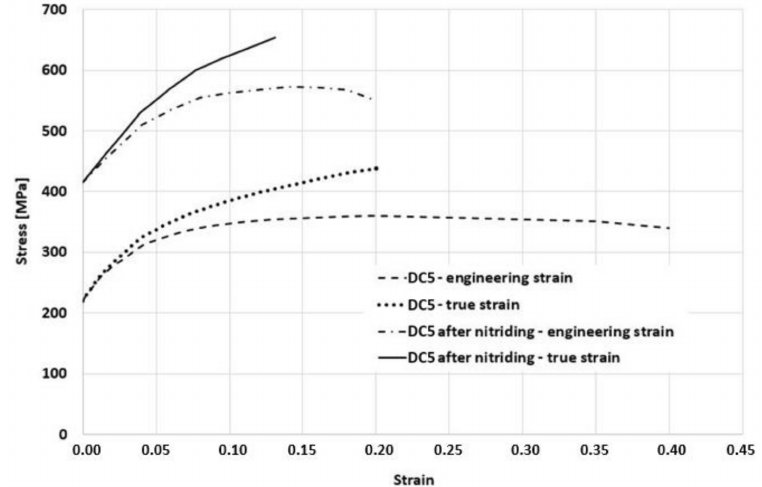
Figure 11. Material characteristics used for FEM modelling.